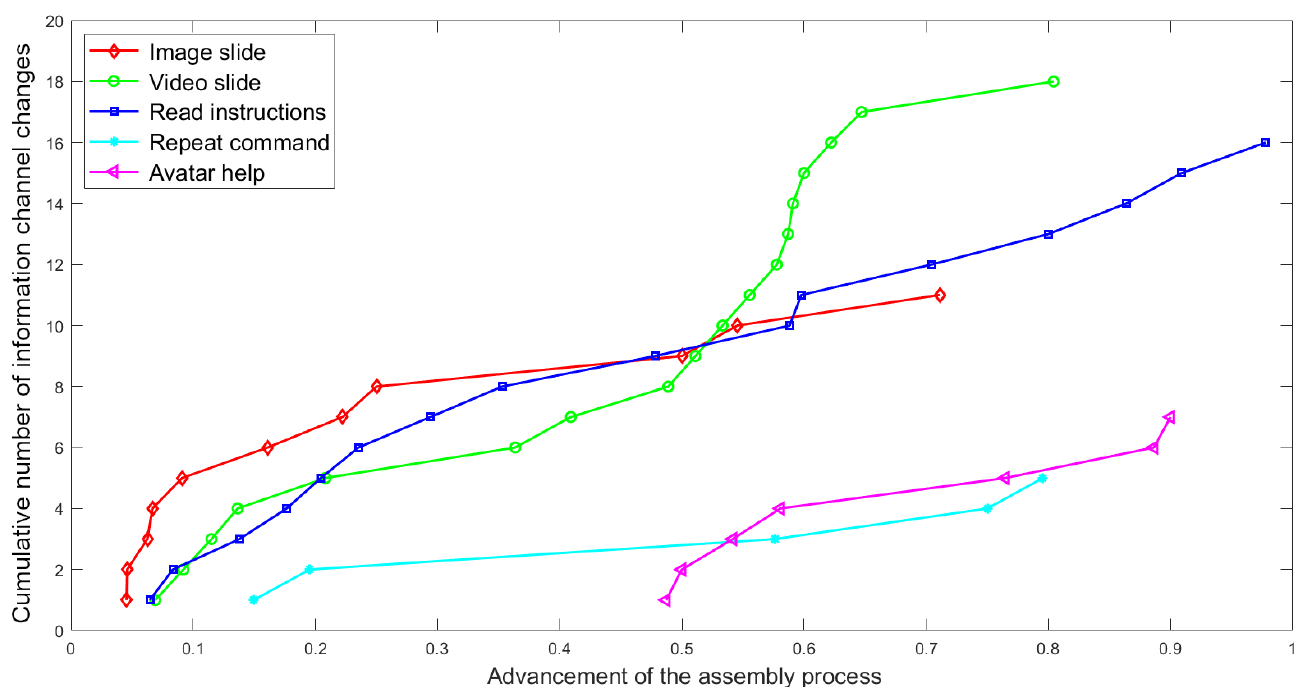
Figure 9. The number of changes of information channels depending on the advancement of the window assembly process using the HINT